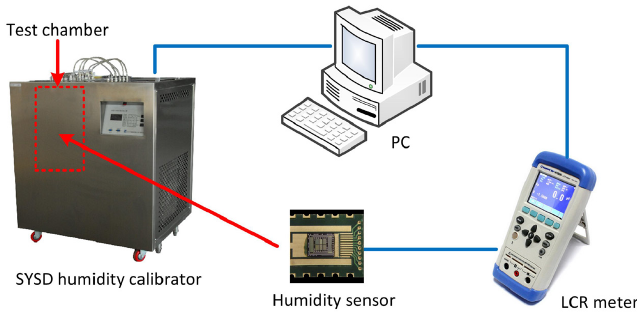
Figure 5. Test system of the humidity sensor for static measurements.